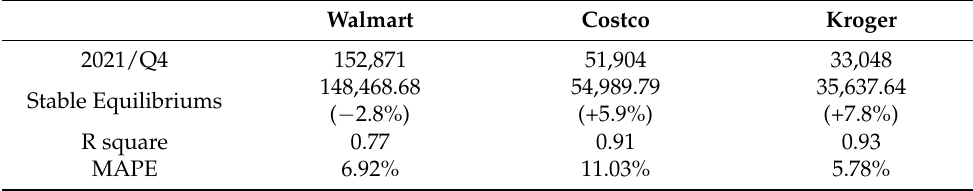
Table 7. Stable equilibriums of sales (million USD) using